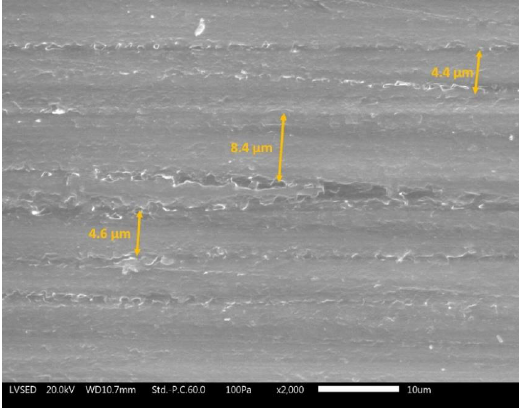
Figure 15. SEM micrographs of sample SG surface morphology after the 2000 scrub test cycles. Materials 2020 , 13 , x FOR PEER REVIEW